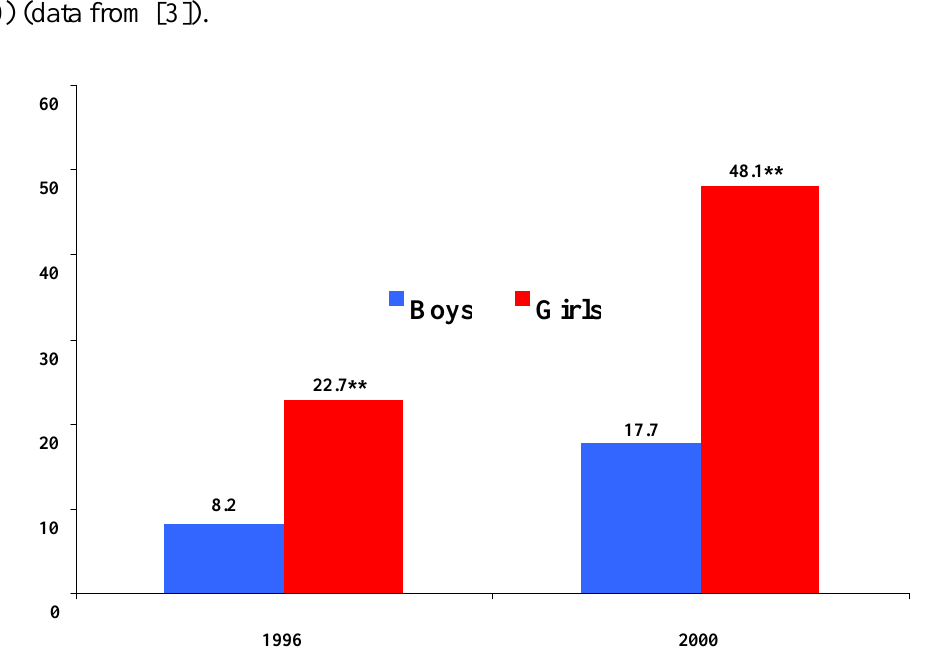
Figure 3. Share of menthol brand preference among Japanese adolescents by gender (1996 & 2000) (data from